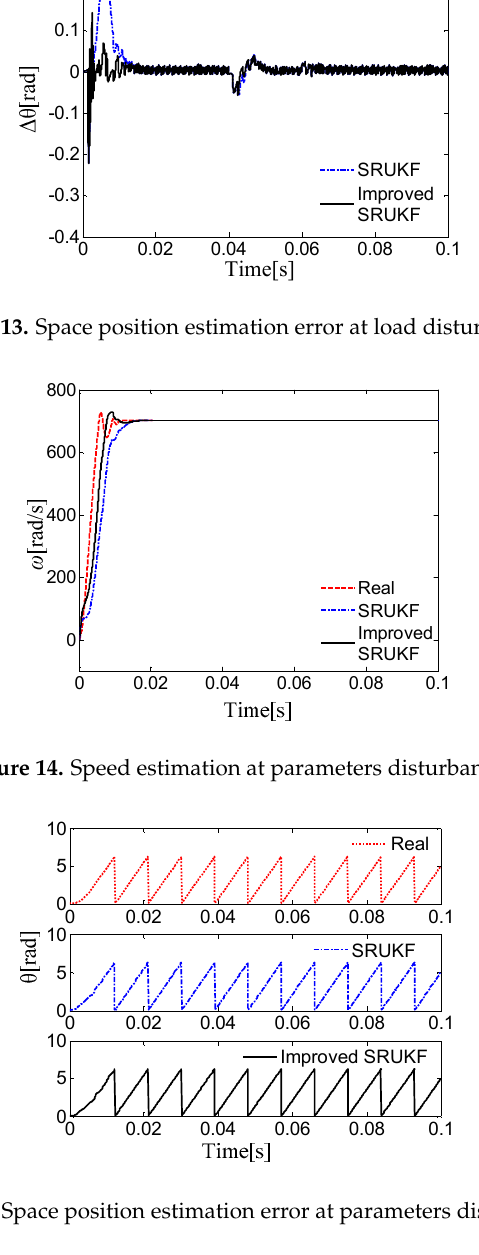
10 of 14 Figure 10. Space position estimation error at speed step response. Figure 11. Speed estimation at load disturbance.